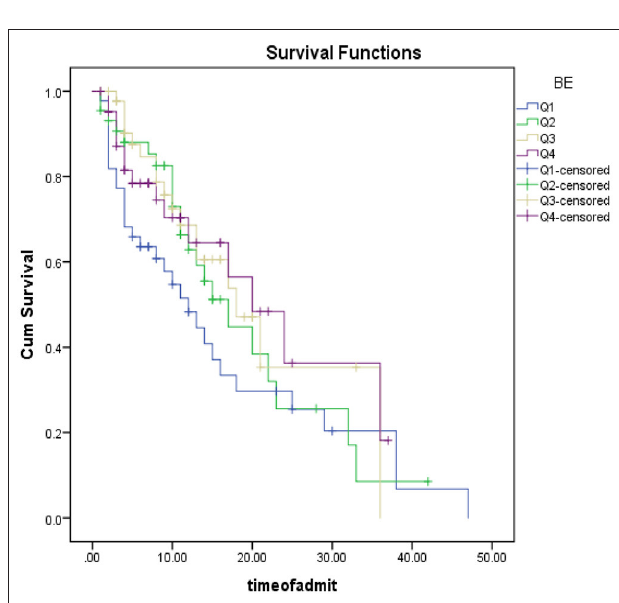
FIGURE 5 | Patient survival analysis based on BE quartiles.